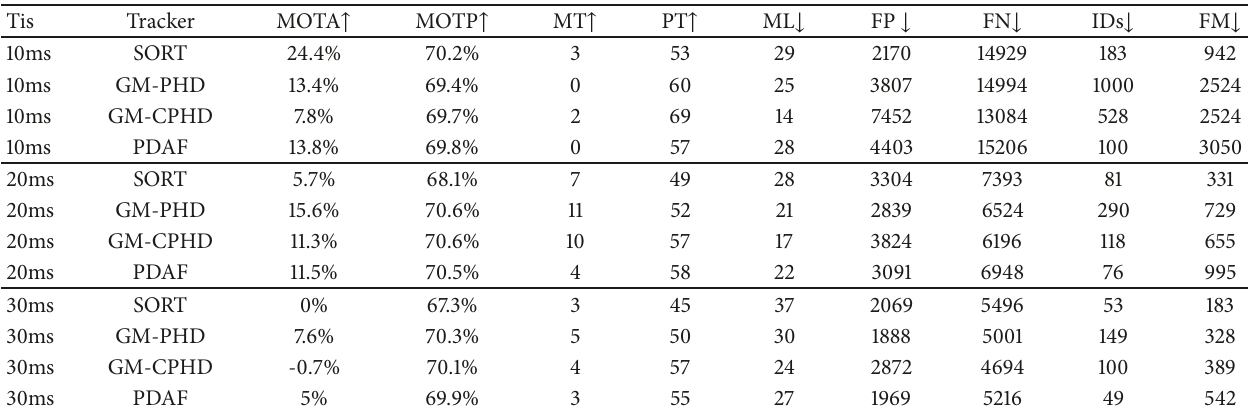
Table 5: The tracking performance for EventSeq-Vehicle2using different tracking methods (SORT, GM-PHD, GM-CPHD, and PDAF) with detection through DBSCAN clustering. The impact of time intervals from 10ms to 30ms was